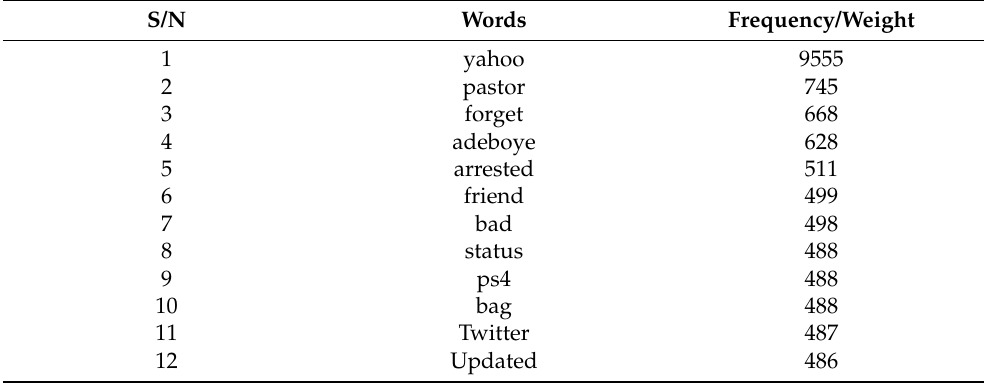
Table 2. The topmost frequent tokens with their